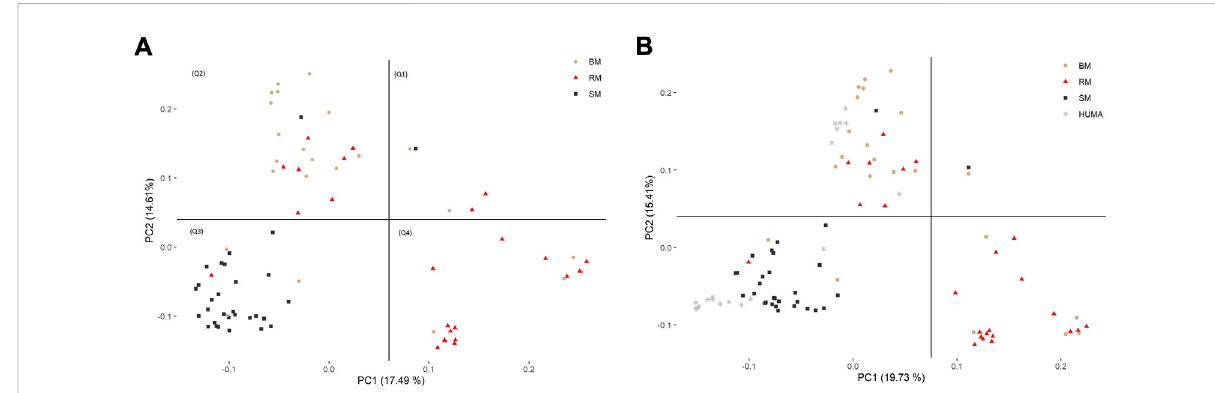
FIGURE 2 DistinguishingBM,RMandSMthroughprincipalcomponentanalysisbasedon10,323SNPmarkers (A) .TheinclusionofHUMAintheanalysis (B) was based on 8,624 SNP markers mapped to the Sus scrofa 10.2 genome assembly. The plotted area is divided into quadrants based on the occurrence of clusters and breeds are distinguished by color and